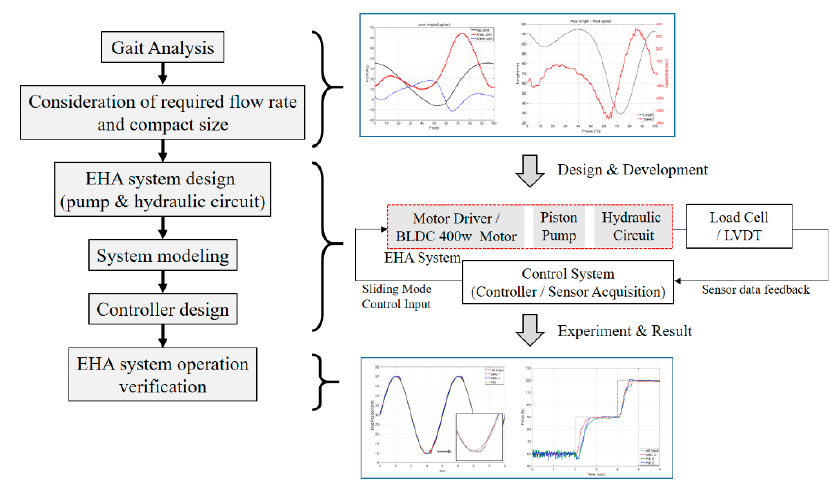
Figure 1. The composition and flow of a paper.